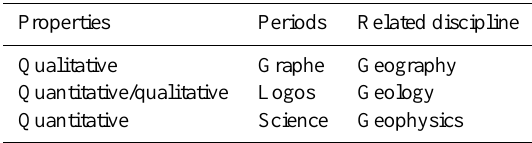
Table 1. Historical development periods of earth